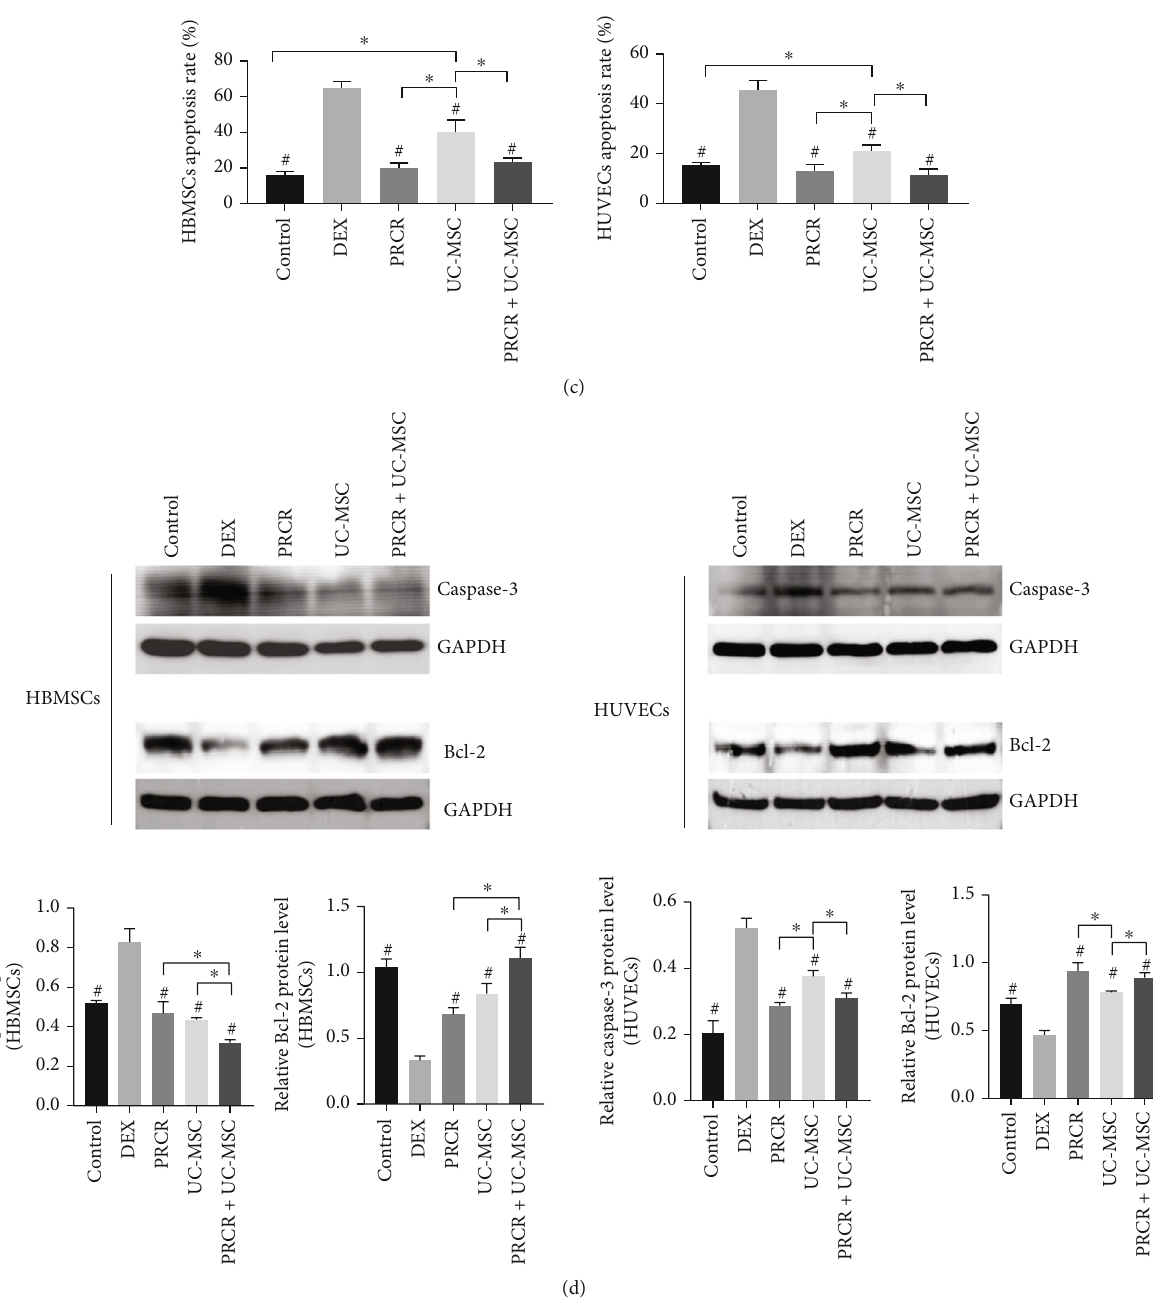
Figure 4: E ff ects of PRCR, UC-MSCs, and PRCR + UC-MSCs on DEX-treated BMSCs and HUVEC apoptosis. (a, b) Representative images of TUNEL-positive cells (apoptotic cells) of DEX-treated BMSCs and HUVEC apoptosis in di ff erent coculture conditions. (c) Quantitative analysis of apoptosis rates of BMSCs and HUVECs, respectively. The PRCR and PRCR+UC-MSCs rescued the DEX-induced apoptotic e ff ects ( P < 0 : 05 ). (d) Western blotting was conducted to evaluate the expression of the apoptosis-related proteins. The PRCR, UC-MSC, and PRCR + UC-MSC groups signi fi cantly blocked caspase-3 activation and increased Bcl-2 expression compared to the DEX group ( n = 5 , # Comparisons between the DEX group and other groups, P < 0 : 05 ; ∗ Comparisons between the two groups, P < 0 : 05 ). PRCR: platelet-rich plasma clot releasate; UC-MSCs: umbilical cord mesenchymal stem cells; DEX: dexamethasone; HBMSCs: human bone marrow mesenchymal stem cells; HUVECs: human umbilical vein endothelial cells; TUNEL: terminal transferase-mediated deoxyuridine triphosphate (dUTP) nick-end labeling; DAPI: 4 ′ , 6-diamidino-2-phenylindole; GADPH: glyceraldehyde-3-phosphate